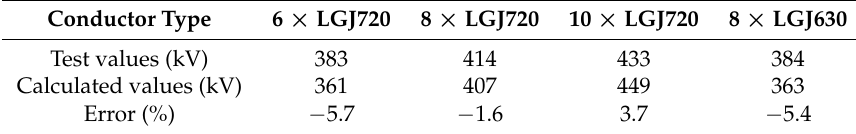
Table 8. Comparison between the test results and calculated values under dry conditions.